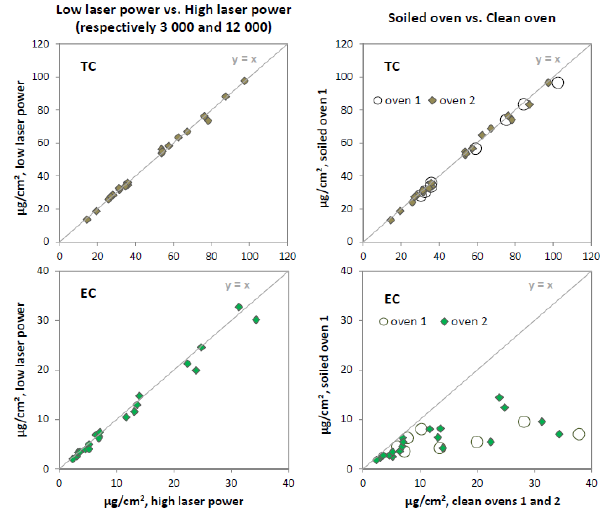
Figure 5. Influence of the laser power (for a clean oven, left panel) Fig. 5. Influence of the laser power (for a clean oven, left panel) and of the oven soiling (extreme case, right 2 and of the oven soiling (extreme case, right panel) on EC measure- panel) on EC measurements. 3